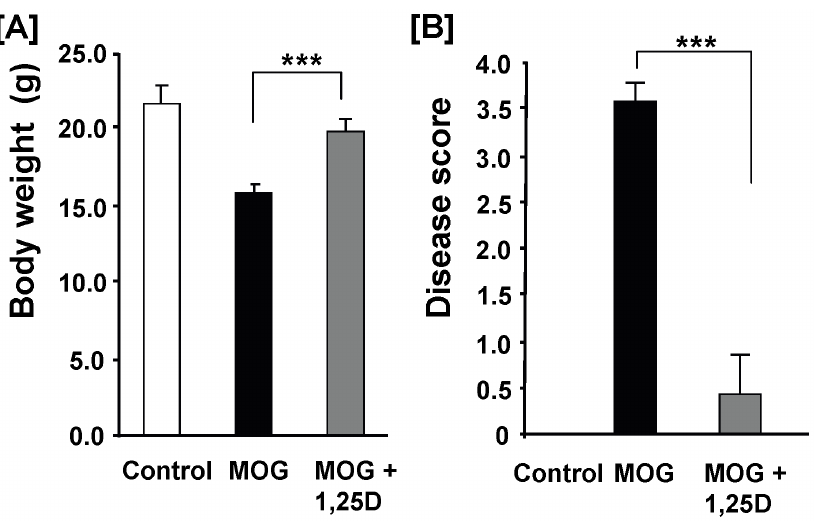
Figure 1. 1,25(OH) 2 D 3 treatment significantly protected mice from development of EAE. EAE was induced by immunonization with MOG ( Material & Methods ). Mice were injected i.p. with 2 m g of 1,25(OH) 2 D 3 one day before MOG injection and then 0.1 m g 1,25(OH) 2 D 3 every other day till day 14 post-MOG injection. Body weight ( A ) and clinical score ( B ) were determined at day 14 post-MOG injection. Data represent the means 6 SEM (n=7) from two independent experiments. *** P , 0.001.